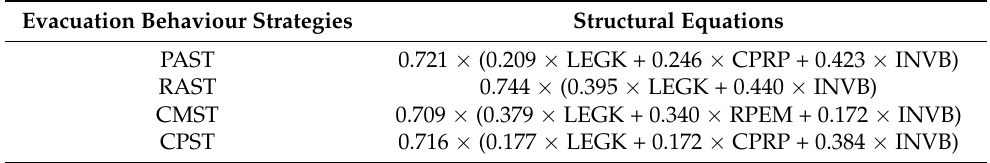
Table 6. Structural equations for the evacuation behaviour